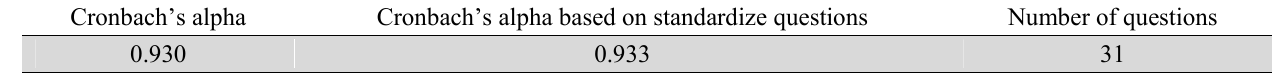
Result of questionnaire’s